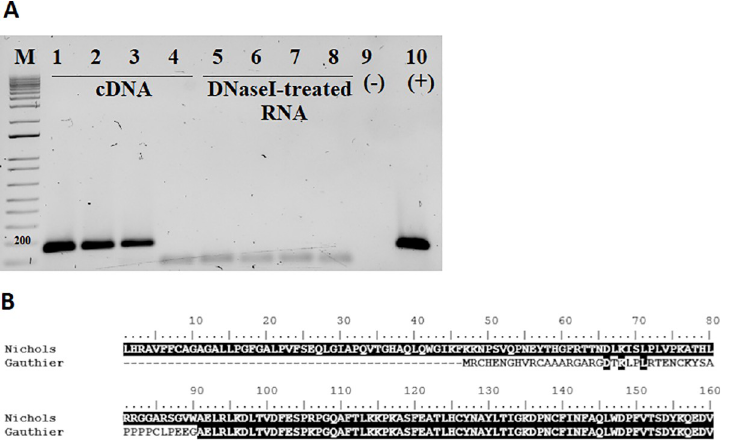
Fig 6. ( A ) RT-PCR analysis of expression of the tp1030 gene in the T . p . pallidum (Nichols, Chicago, and Sea81-4; line 1–3, respectively) and T . p . pertenue (Gauthier; line 4). No amplification was detected in DNaseI-treated RNA samples before reverse transcription (line 5–8). NTC: No template control (line 9). Positive control is Nichols DNA (line 10). M: molecular size marker. Amplification of the control gene tp0574 (encoding the 47 KDa lipoprotein) yielded positive signal from all cDNA samples. ( B ) Comparison of the TprL NH 2 -termini of T . p . pallidum and T . p . pertenue (Nichols and Gauthier strains, respectively).